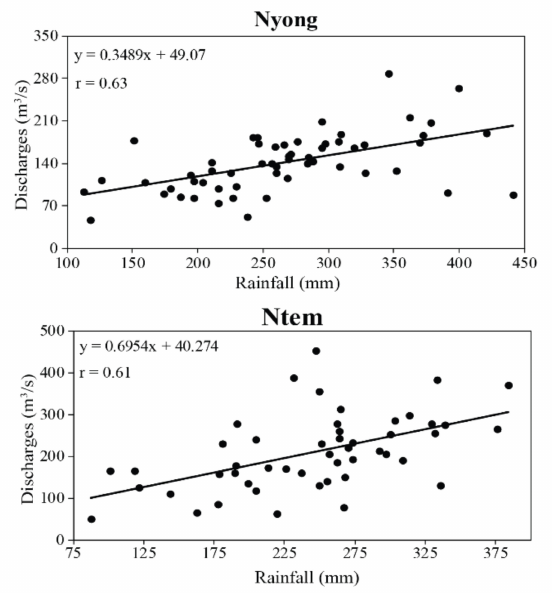
Figure 7. Regression between September (first month of autumn) discharges and summer (July and August)